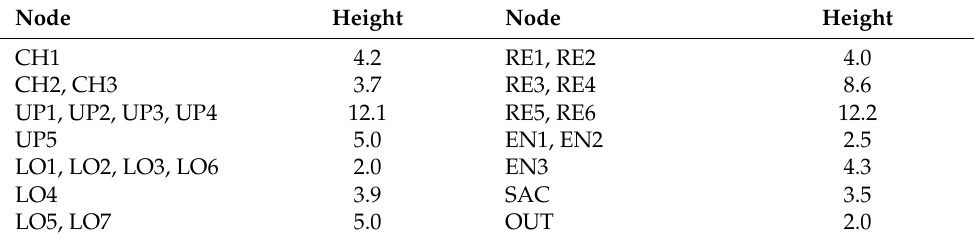
Table 2. Distance of the nodes (height, in m) from the floor level of the central nave of the church. Node Height Node Height